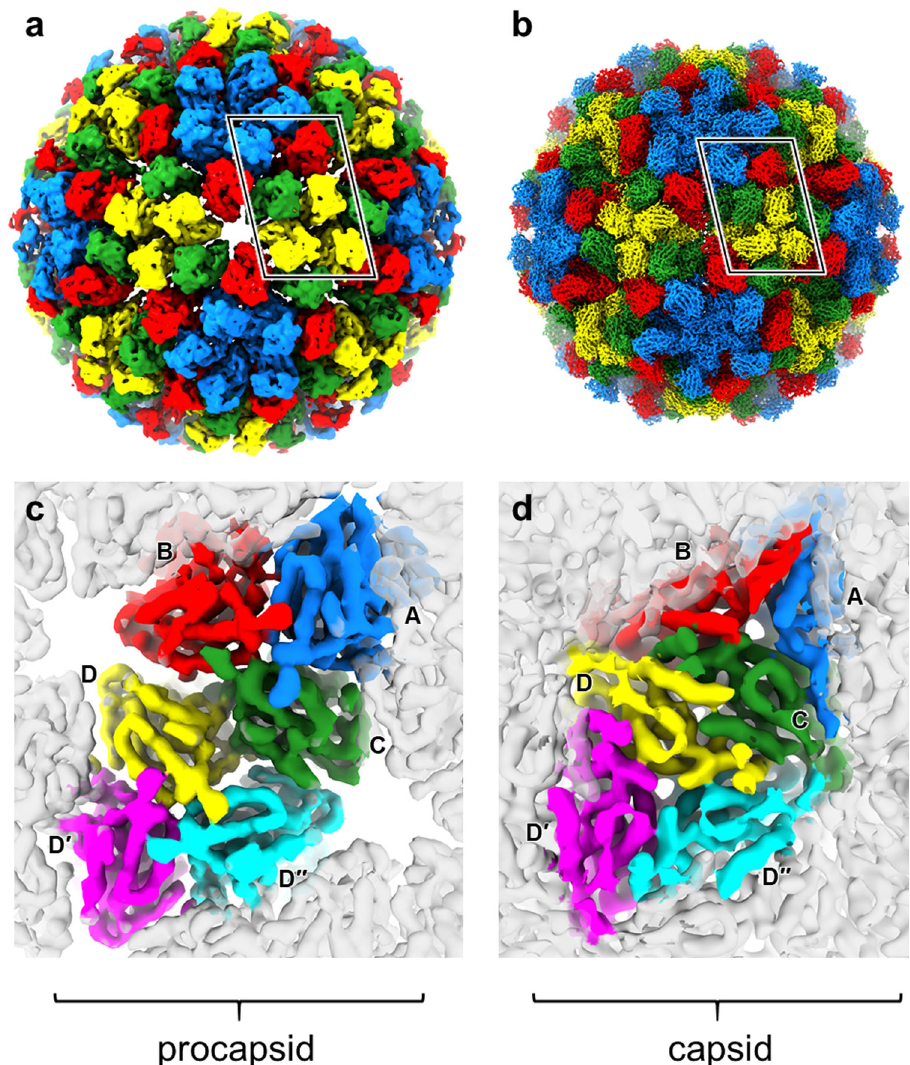
Fig. 5 Cryo-EM reconstructions of N ω V VLPs highlighting the quaternary structures. Reconstructions of a the procapsid at 6.6 Å resolution and b the capsid at 2.7 Å resolution as viewed down the icosahedral two-fold axis. The density associated with four 70 kDa subunits that comprise the icosahedral asymmetric unit are coloured: A — blue, B — red, C — green and D — yellow. The highlighted region is shown below as viewed from the core of the particle for c the procapsid and d the capsid. The density for the rest of the particle is shown in semi-transparent grey. For ease of comparison the capsid density has been down-sampled to 6.6 Å resolution in d . In both the lower panels, subunits A – C are arranged around a quasi-three-fold axis and three copies of subunit D are arranged around the icosahedral three-fold axis (D – yellow; D ′ – magenta; D ″ – cyan; N.B. these are all yellow in a , b — different colours are used here to clearly de fi ne the densities associated with each subunit). Since icosahedral symmetry was imposed during reconstruction, the density associated with the three D-type subunits will be identical within each map. It is clear from these comparisons that the symmetry is very strong around the quasi-three-fold axis (A – C) in the procapsid but is broken in the capsid. Indeed, the subunit conformations and arrangements around the two types of three-fold axes are closely similar for the procapsid (A – C vs. D – D ″ ). Additionally, these views highlight the porous packing seen in the procapsid relative to the highly compact arrangement of subunits in the